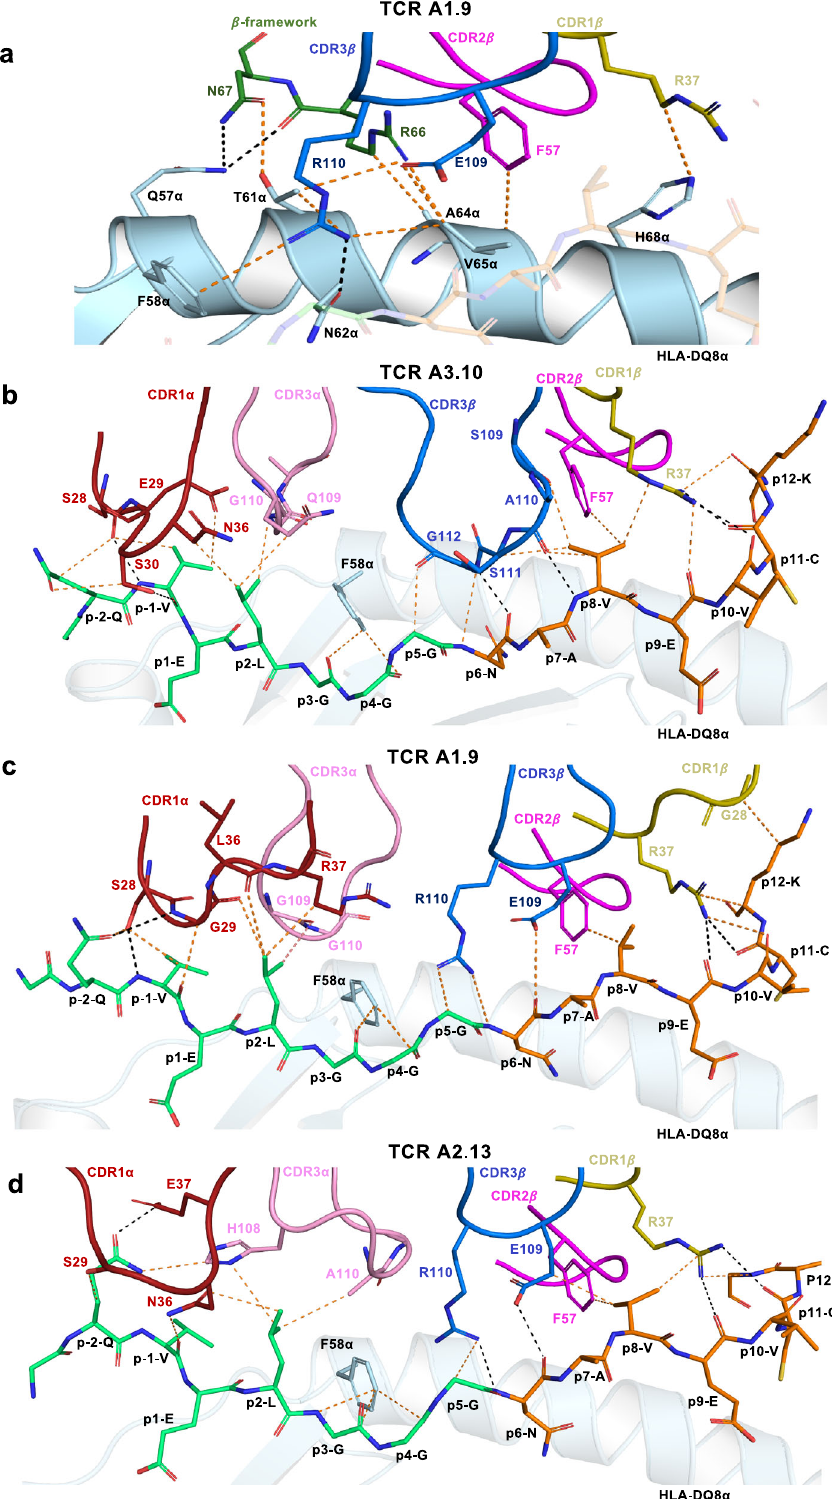
Fig. 5 Interactions at the TRBV5-1 + TCR-HLA-DQ8-HIPL11C interface. a Conserved interactions between TRBV5-1 + TCR CDR β loops; β -framework and the HLA-DQ8 α -chain using TCR A1.9 as an example. The HLA-DQ8 α -chain is coloured in neon. Whilst the CDR1 β , CDR2 β , CDR3 β loops and β -framework are in gold, magenta, blue, and green, respectively. b – d The CDR loops of A3.10, A1.9 and A2.13 TCRs make conserved contacts with the HIPL11C peptide. The CDR1 α and CDR3 α loops are coloured in red and pink, respectively, and the CDR β loops colours as described above. The HIPL11C peptide is coloured such that the C-peptide fragment is in lime-green and the IAPP2 fragment in orange. Hydrogen bonds (H-bonds) are denoted as black dashed lines, whilst vdW interactions are presented as orange dashed lines. Cartoon representations of the interactions between the CDR loop and HLA-DQ8-HIPL11C are shown with oxygen atoms in red and nitrogen atoms in